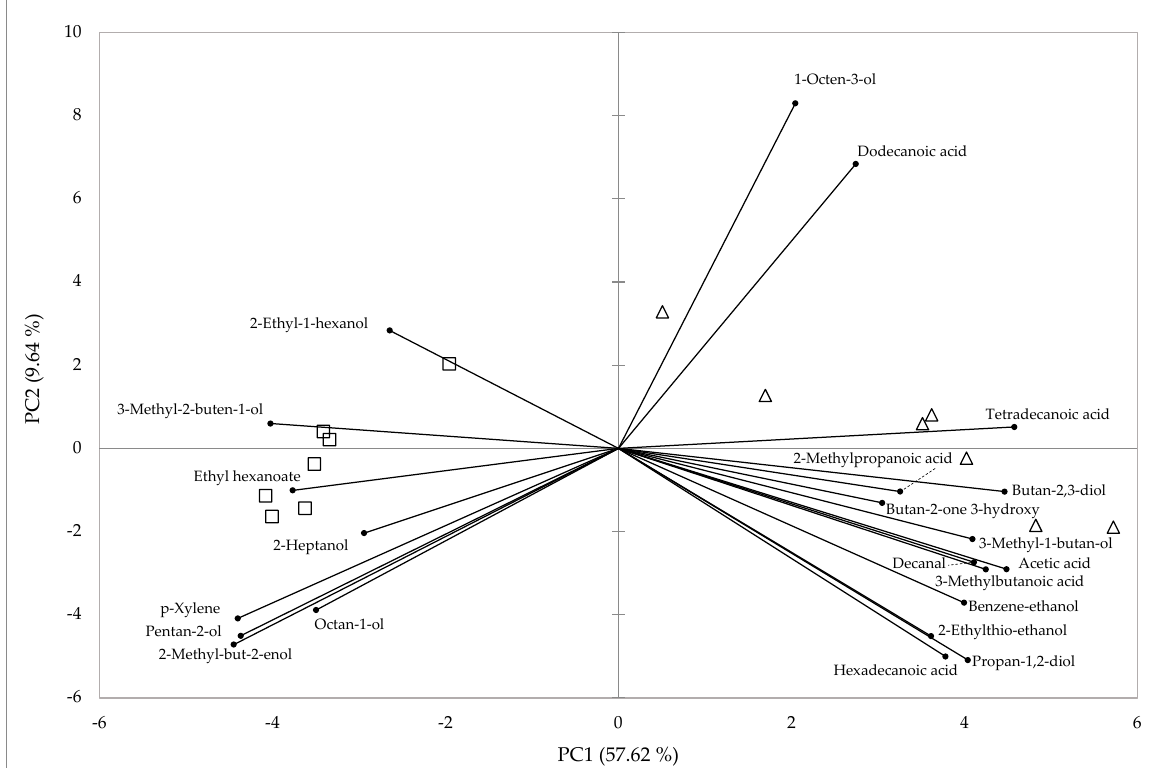
Figure 1. Principal component analysis plot representing the differentiation of Roja Mallorquina ewes’ cheeses based on the main volatile compounds. △ , fresh soft cheese; □ , ripened cheese.